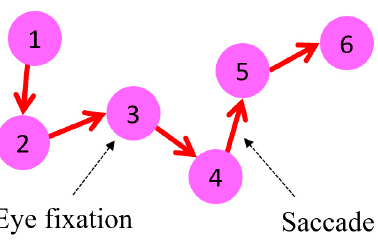
Figure 1. Representative example of a scanpath.